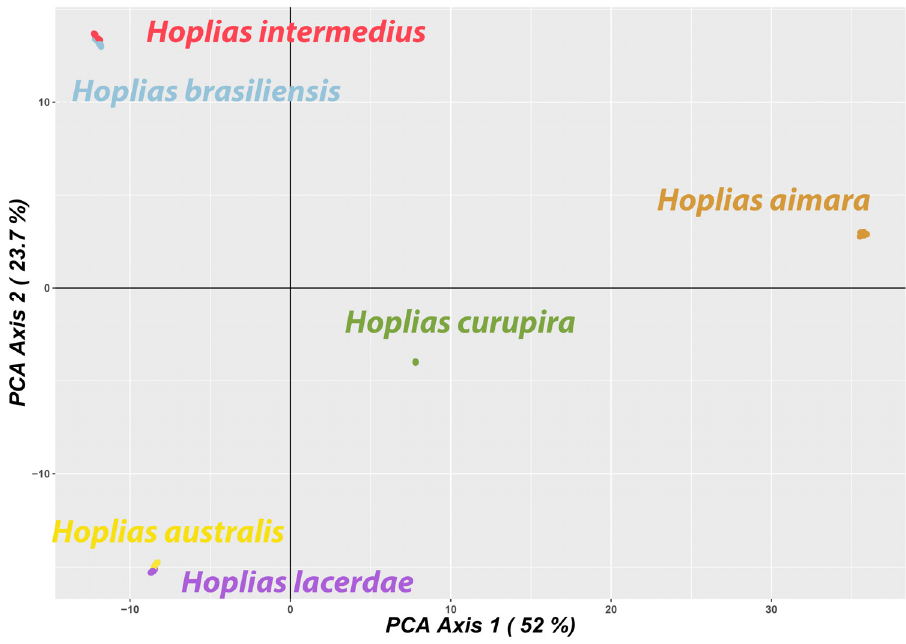
Figure 5. Principal coordinate analysis of giant trahiras. The color scheme for each species follows the same used in Figure 1.